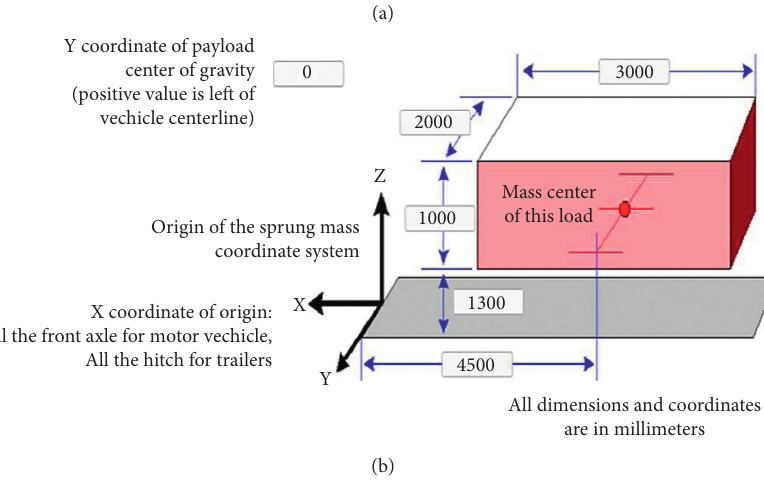
Figure 3: Properties of a truck. (a) Dimensions. (b) Load